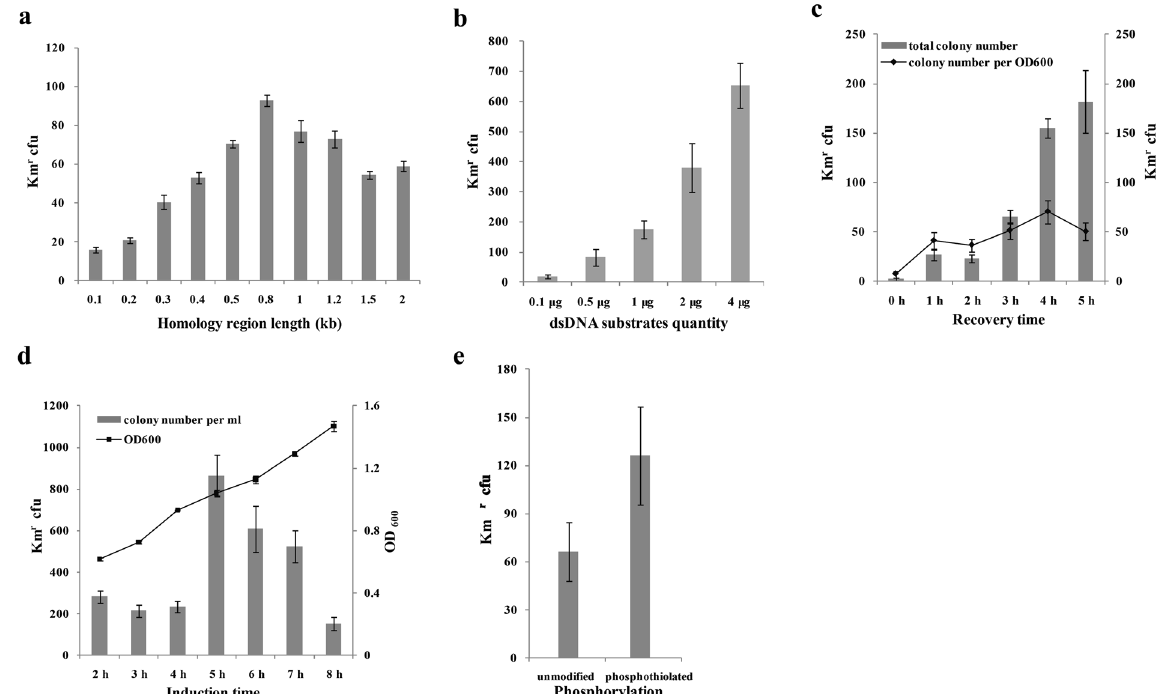
Figure 1. Optimization of linear dsDNA recombineering parameters. ( a ) Effect of the homology length of linear dsDNA on recombination efficiency. 100, 200, 300, 400, 500, 800, 1000, 1200, 1500, 2000 bp left and right homology arms of the crtB gene combining with the Kan cassette were used for the investigation. 0.5 μ g dsDNA cassettes were used for electroporation. The recovery time was 5 h. ( b ) Effect of the quantity of linear dsDNA on recombination efficiency. 0.1–4 µ g CrtB/800-Kan cassettes were used for electroporation. The recovery time was 4 h. ( c ) Effect of the recovery time on recombination efficiency. The recovery time was 0 h to 5 h. 0.5 μ g CrtB/800-Kan cassettes were used for electroporation. The total number of colony of per OD 600 also is shown. ( d ) Effect of the induction time on recombination efficiency. The RecET recombinases were induced for 2–8 h. 0.5 μ g CrtB/800-Kan cassettes were used for electroporation and the recovery time was 4 h. OD 600 of the harvested culture is also shown. ( e ) Effect of the phosphothiolated linear dsDNA on recombination efficiency. 0.5 μ g CrtB/800-Kan cassettes were used for electroporation. The recovery time was 4 h. All of the Km r cfu is the number of kanamycin resistance colony per mL. Datas are the means of at least three experiments with standard deviations by error